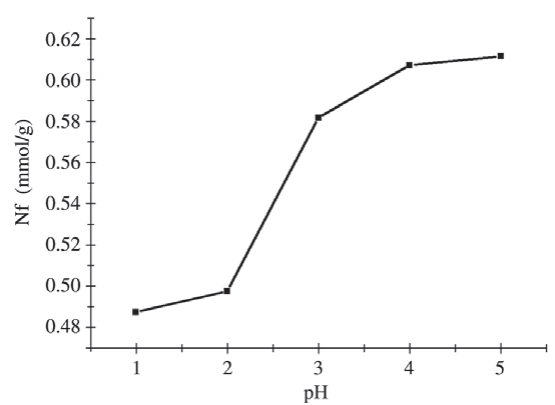
Figure 3. Effect of the pH value on sorption of Cu(II) ions onto Cell-PAB at room temperature.